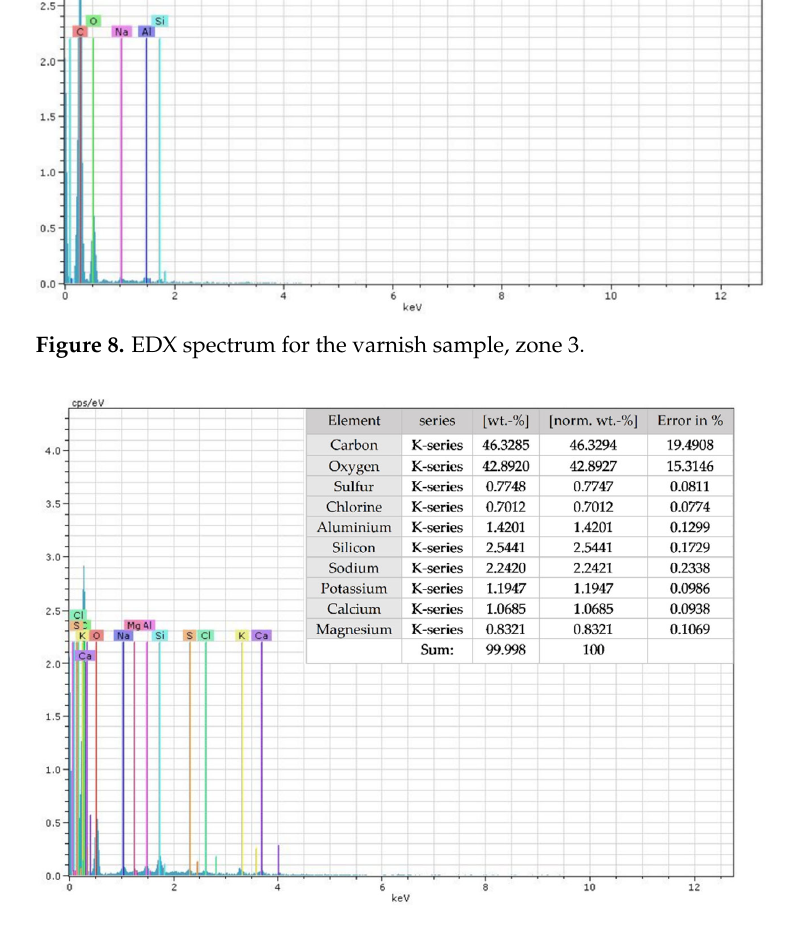
Figure 9. EDX spectrum for the varnish sample, zone 4.